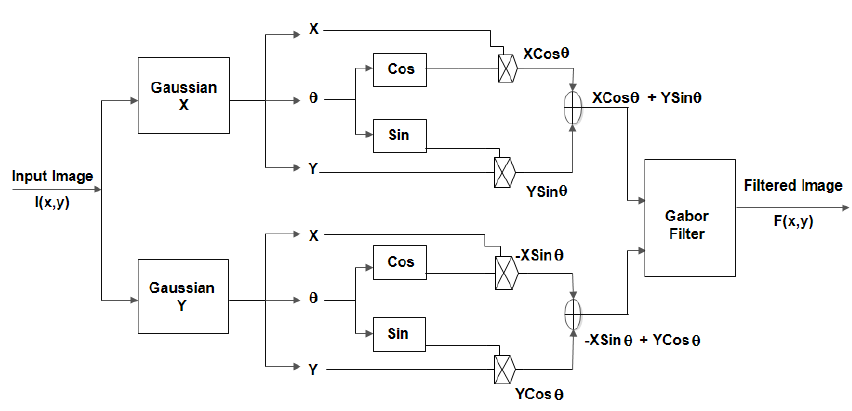
Figure 1. Block diagram of the proposed Image Denoising using the Gabor Filter. The RGB image is converted to a grey-scale image at pre-processing stage where a pixel size of 8-bits is chosen to have the range of quantization levels from 0 to 255. Here, each pixel is a shade of grey between black and white. In this work, 256 × 256 pixel size is considered for the input. Figure 2 shows the grey image for the given input test image. The Grey image is then transformed into a binary image. The intensity values in a binarized image for each pixel can either be black or white: 0 for black and 1 for white. These types of images are more efficient for storage and are used in many applications such as fingerprints, texts, etc. The image obtained here is I ( x , y ) where the spatial coordinates x and y will later undergo a filtering process with kernel functions. Input image I ( x , y ) is convolved with Gabor kernel coefficient gb ( x , y ) to form a filtered image F ( x , y ) . The Gabor kernel filters the input image for certain